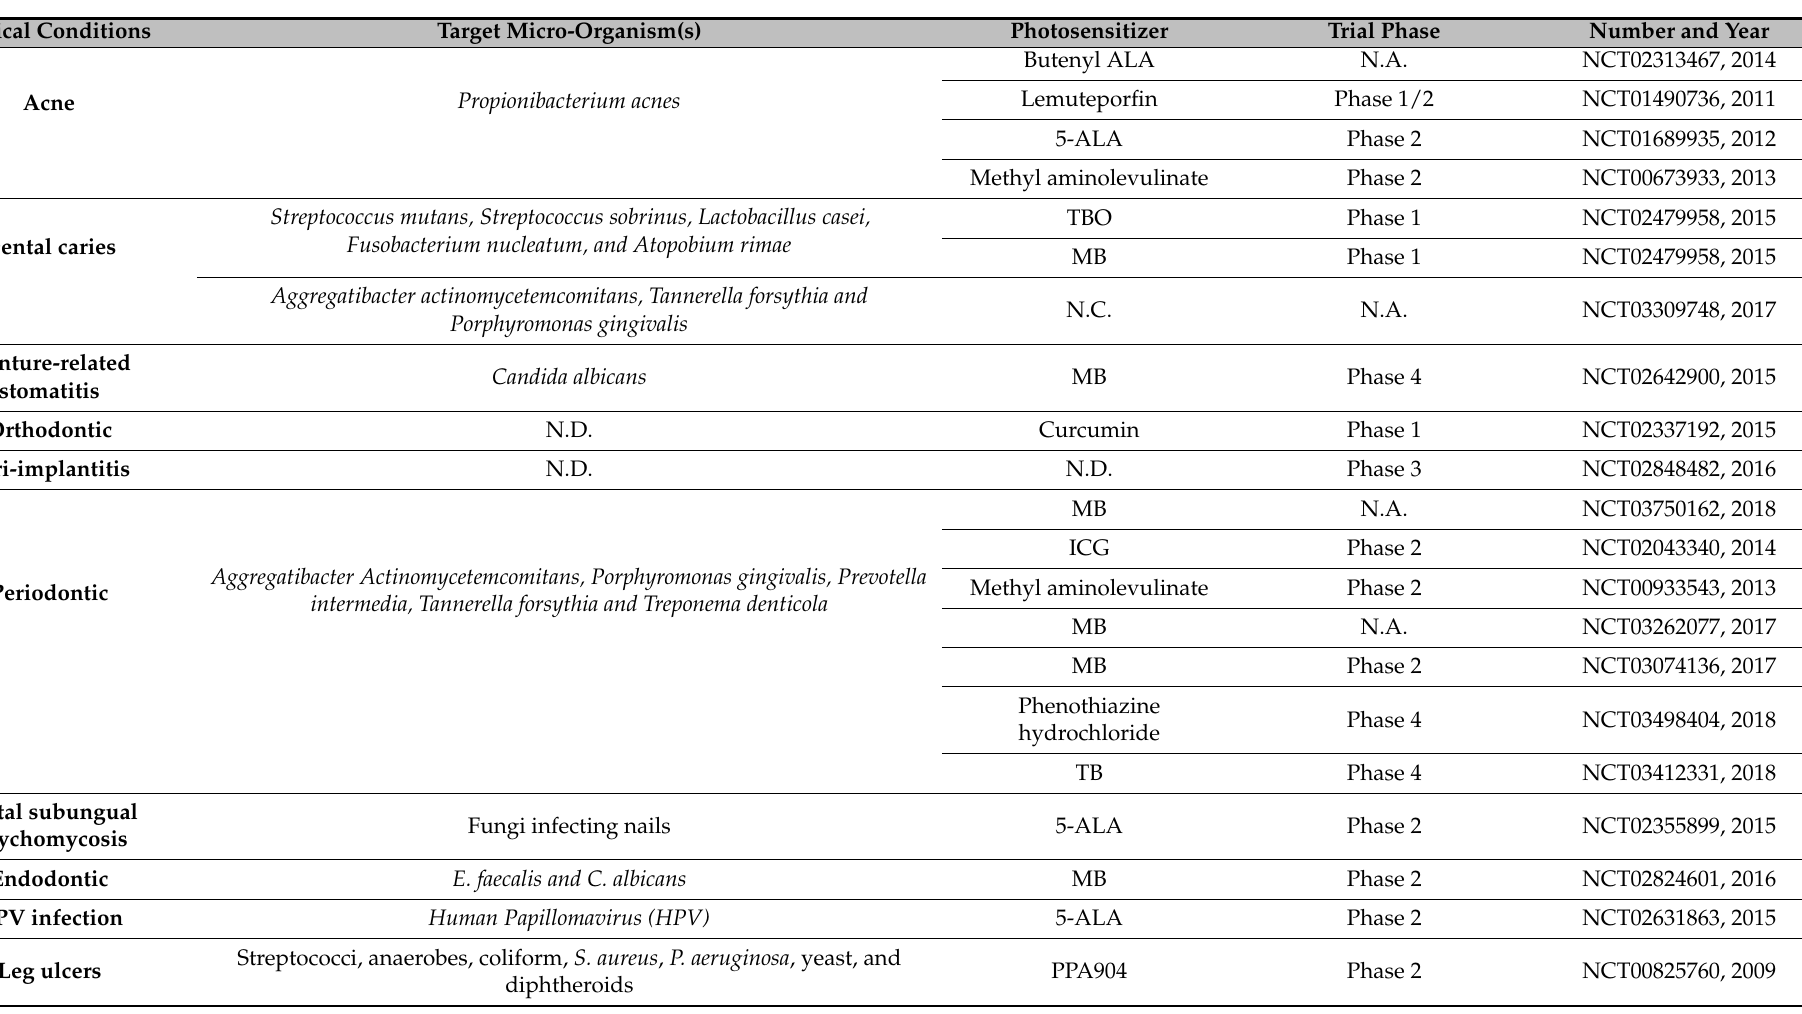
Table 1. List of some recently completed or terminated clinical trials that evaluated aPDT to treat diverse infectious